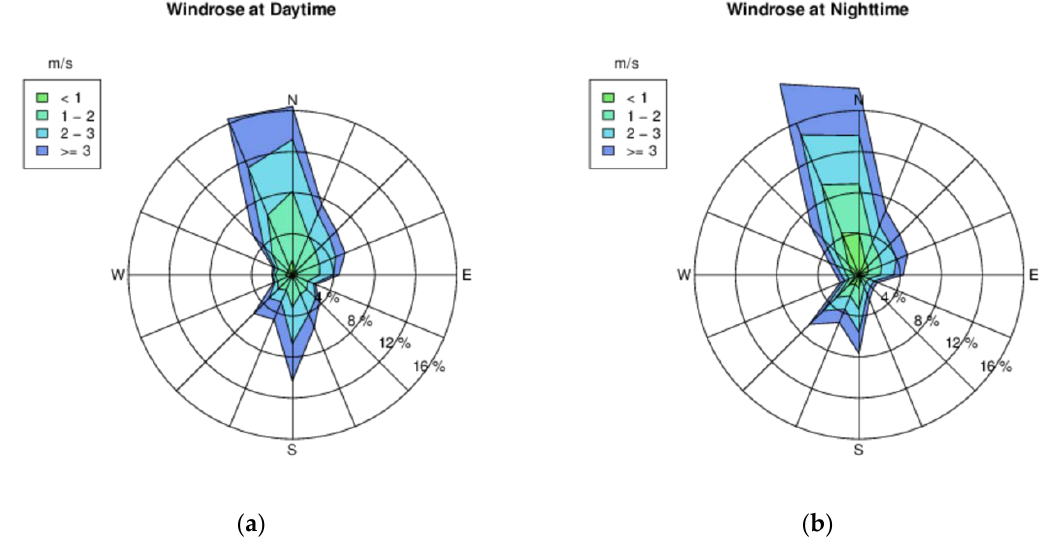
Figure 2. Wind roses showing the distribution of wind speed and direction in 1.1 m above ground for Tokyo City based on the period August 1966 to June 2018 at day ( a ) and nighttime ( b ).